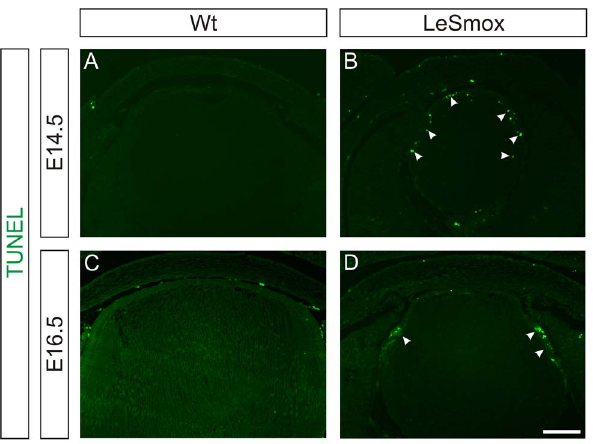
Figure 9. Cell death in LeSmox lenses. TUNEL reaction in wild-type ( A, C ) and LeSmox ( B, D ) lenses at E14.5 ( A, B ) and E16.5 ( C, D ). In wild- type lenses ( A, C ) no distinct TUNEL + nuclei were detected. In E14.5 LeSmox lenses ( B ) numerous TUNEL + nuclei were detected throughout the epithelium and occasionally in fibre cells in the transitional zone. At E16.5 ( D ), TUNEL + nuclei were concentrated in the equatorial zone at or just anterior to the equator. Scale bar, A–D , 100 m m.